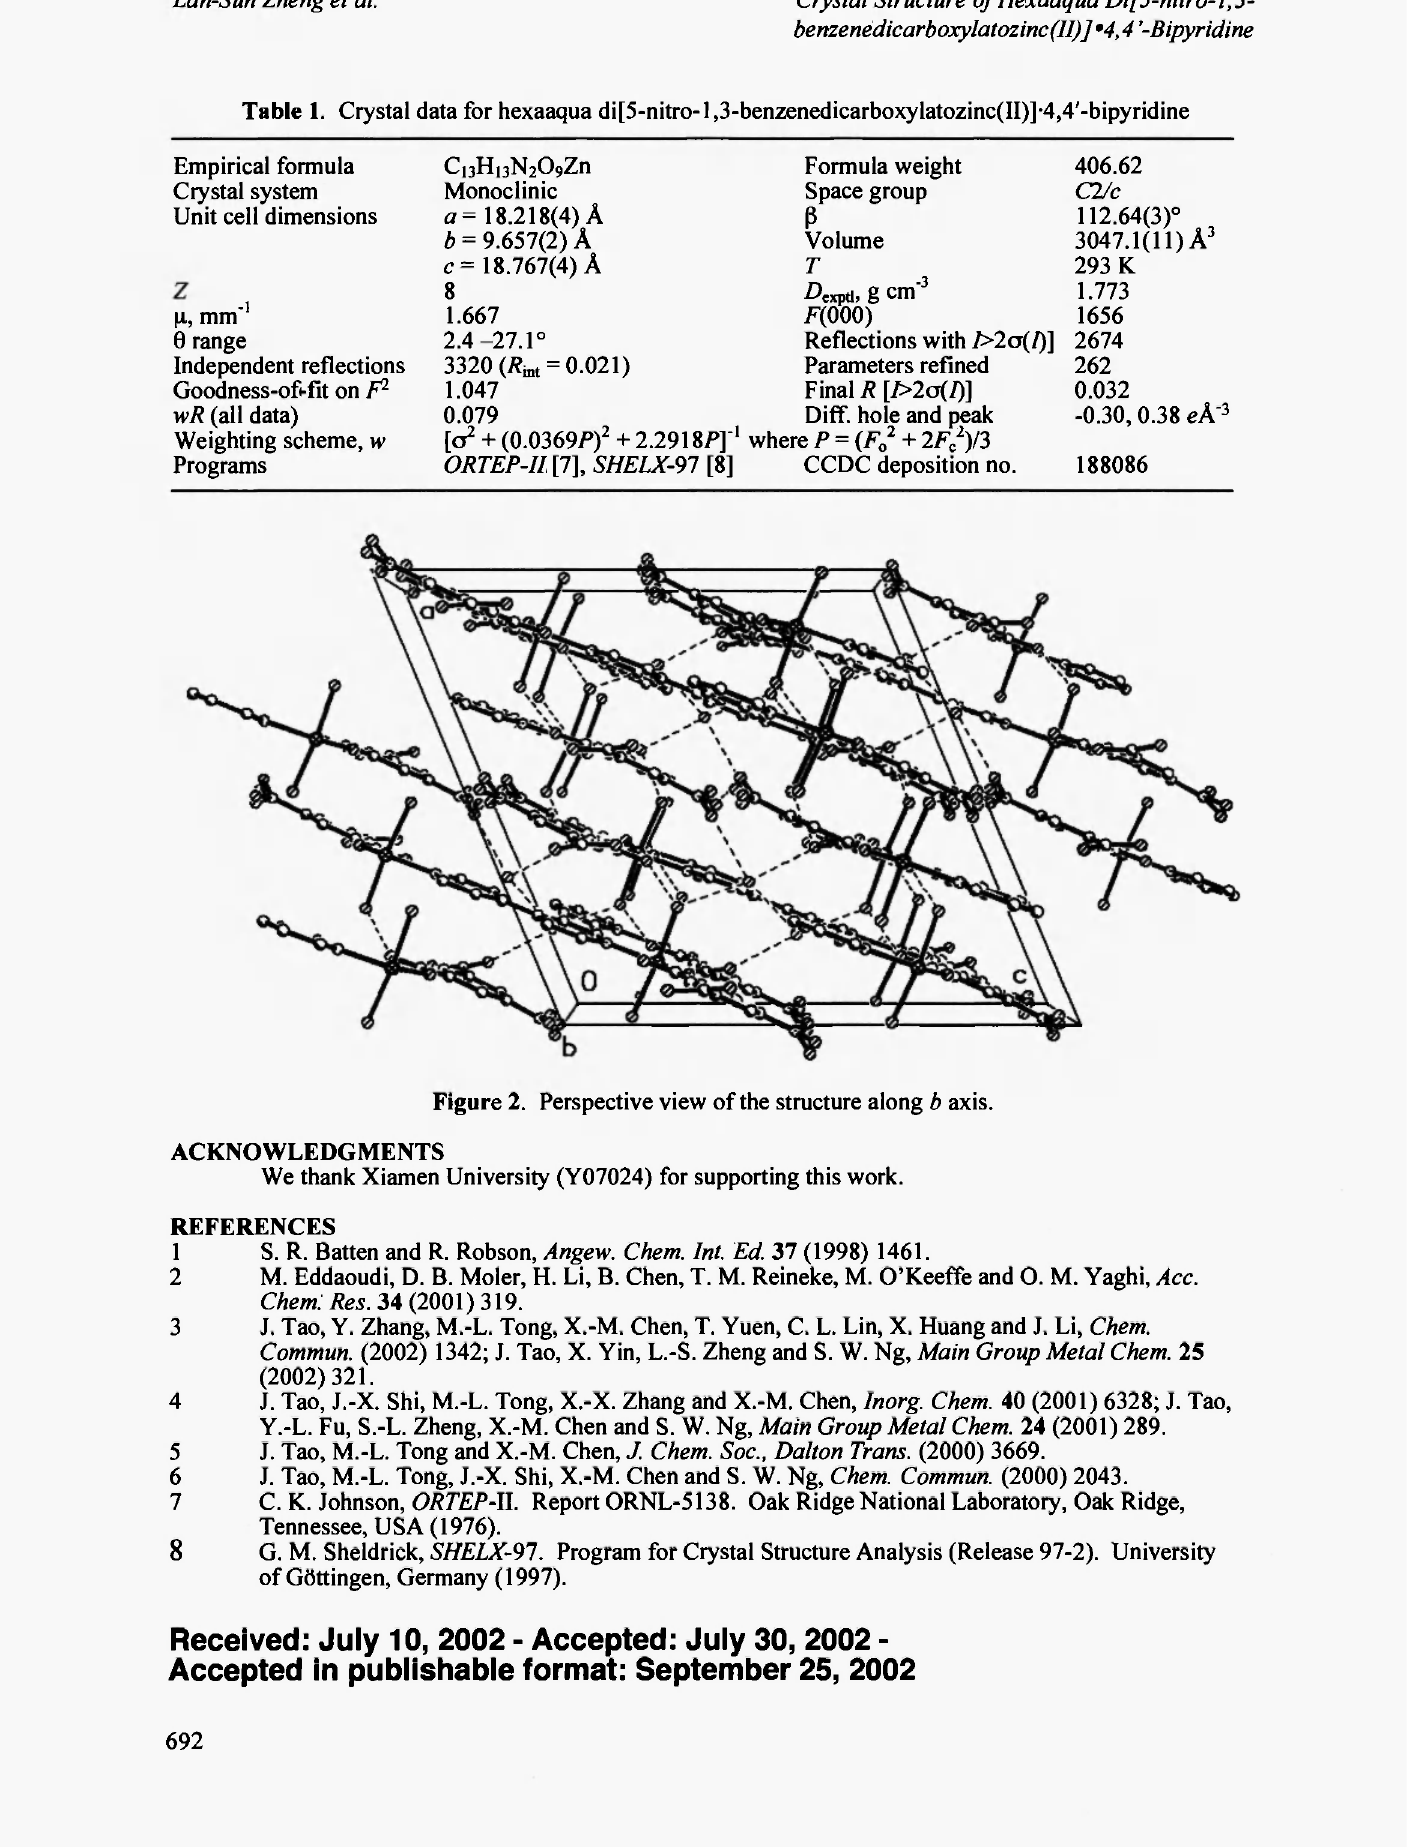
Table 1. Crystal data for hexaaqua di[5-nitro-l,3-benzenedicarboxylatozinc(II)]-4,4'-bipyridine